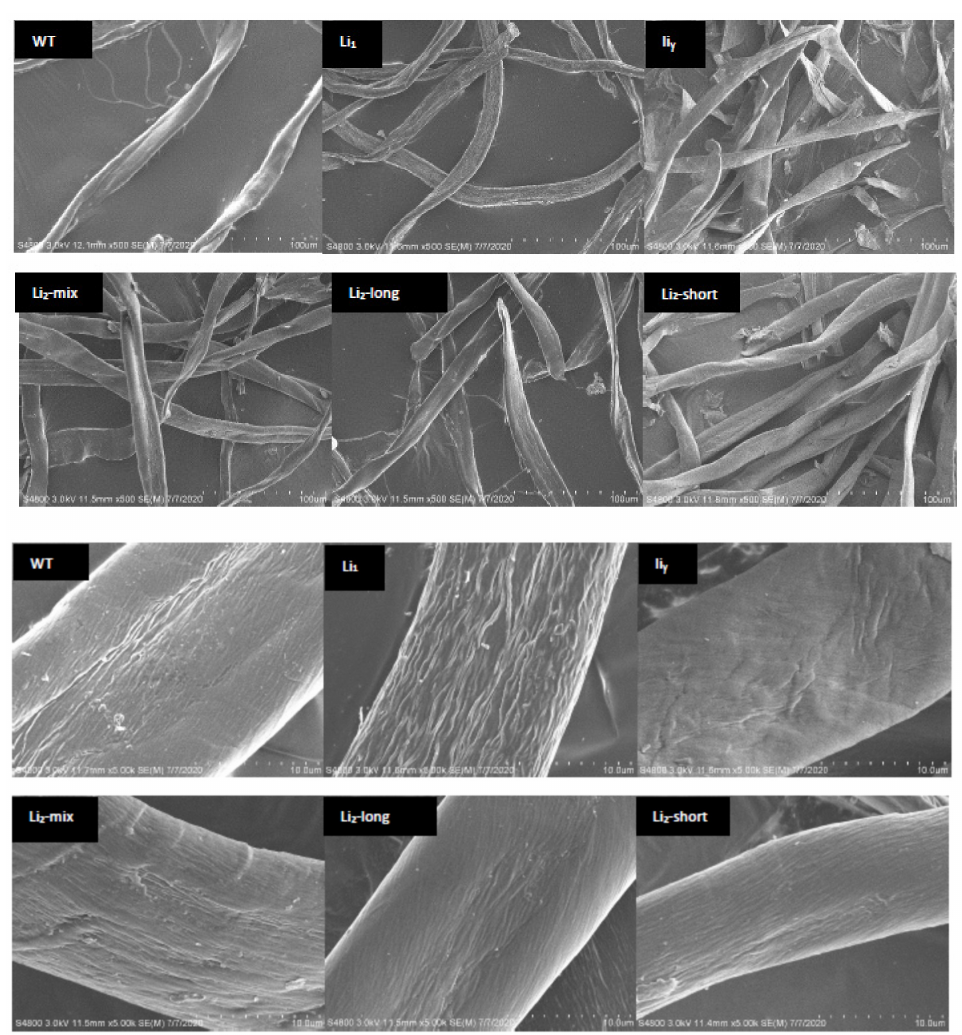
Figure 4. SEM images of six cotton fiber samples. The bar distance is 100 and 10 µ m, respectively, for upper and lower